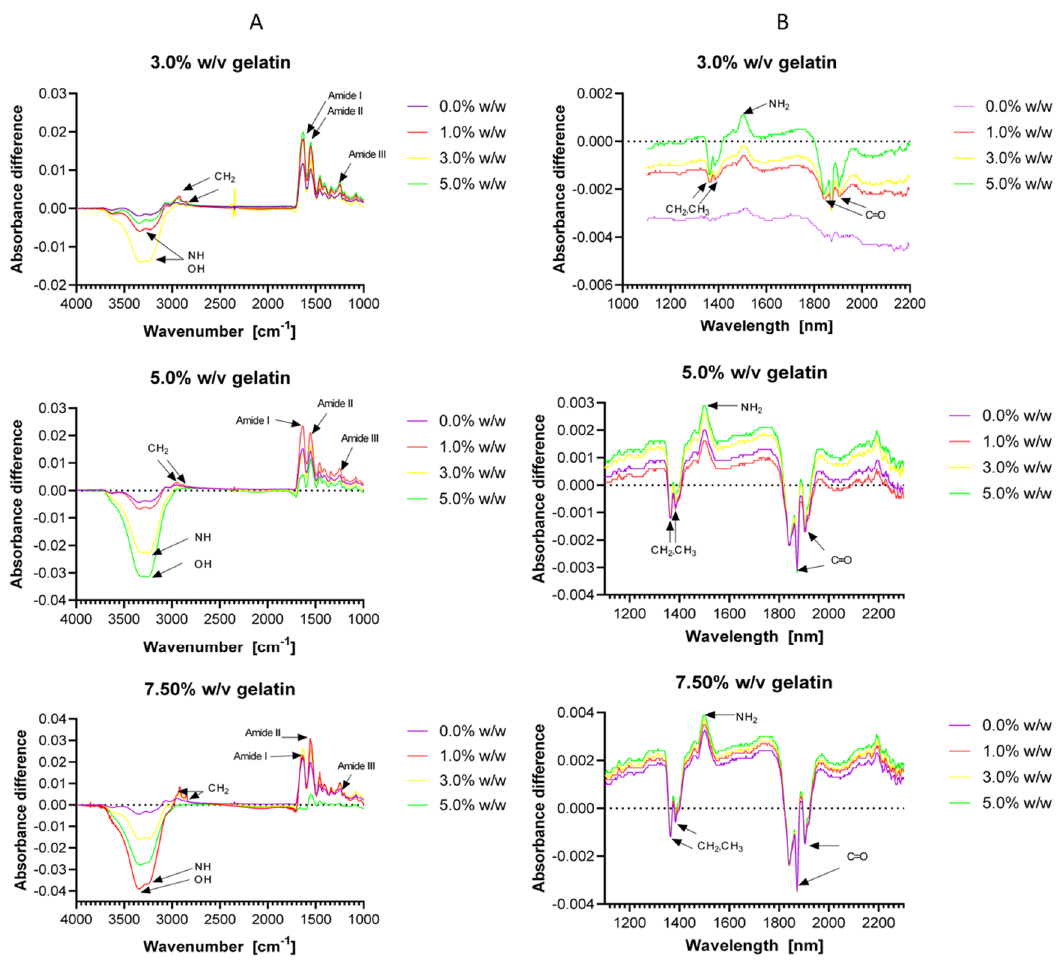
Figure 3. Fourier transform infrared (FTIR) ( A ) and near-infrared (NIR) ( B ) spectra obtained for hydrogels formulations with 3.0%, 5.0% and 7.5% ( w/v ) gelatin and for concentrations of GTA of 0.0%, 1.0%, 3.0% and 5.0% ( w/w ). Some relevant peaks are indicated in the spectra for the precise identification (see discussion) of the material functional groups.